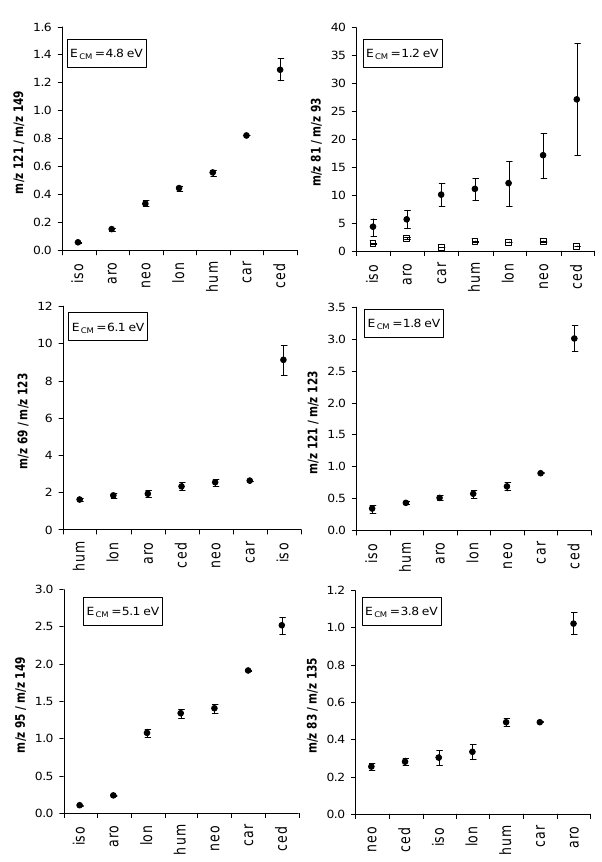
Fig. 6. Selected fragment ion intensity ratios from the fragmenta- tion of protonated SQT. Error bars correspond to 2 σ